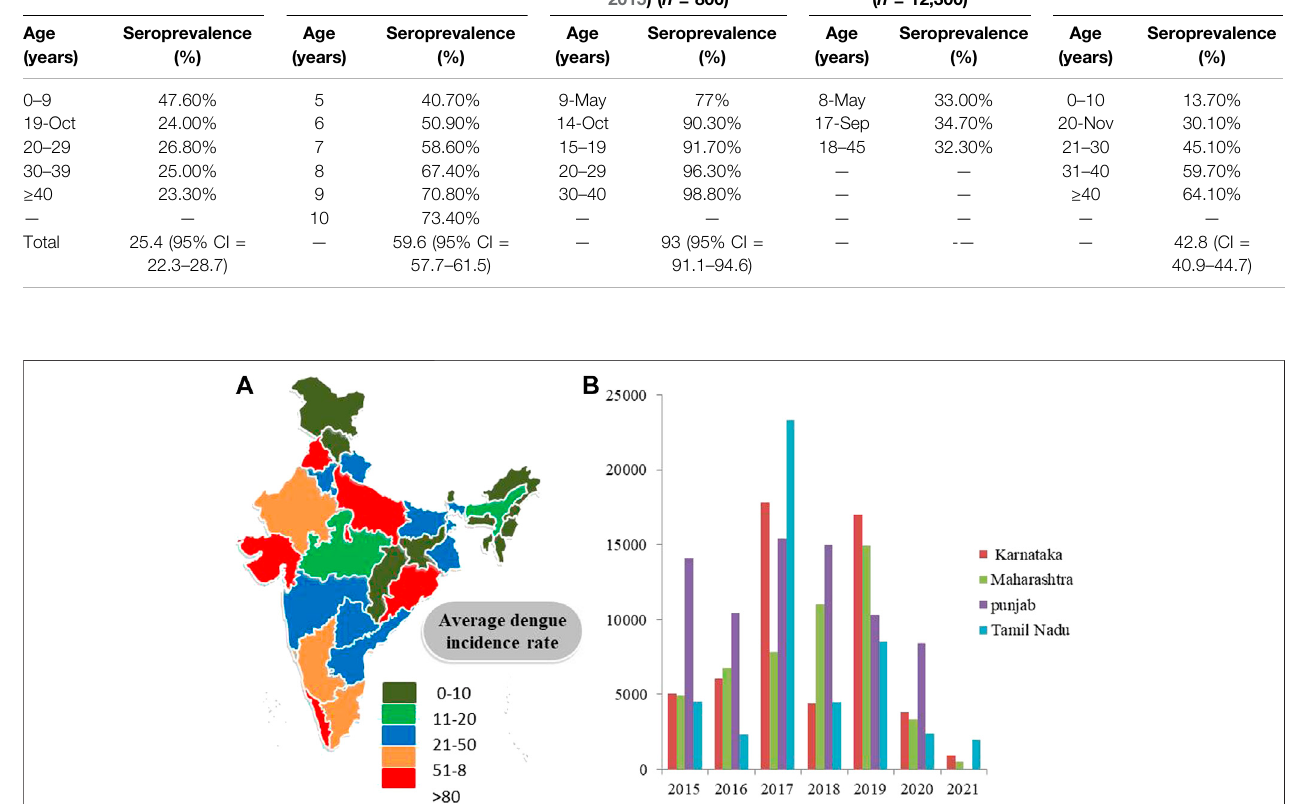
FIGURE2|(A) DenguecasesindifferentregionsofIndia2021. (B) State-wisedistributionofdenguecases( y -axis)infourstatesofIndiafrom2015to2021( x -axis) (Source: National Vector Borne disease Control Programme).